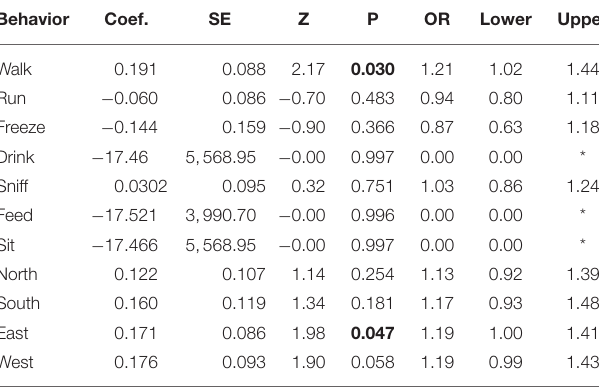
TABLE 2 | Likelihood estimates in Binary Logistic Regressions with number of cat sightings as predictor of behavior for rats at a semi-enclosed industrial building in New York City from Dec. 27, 2017—May 28, 2018. Behavior